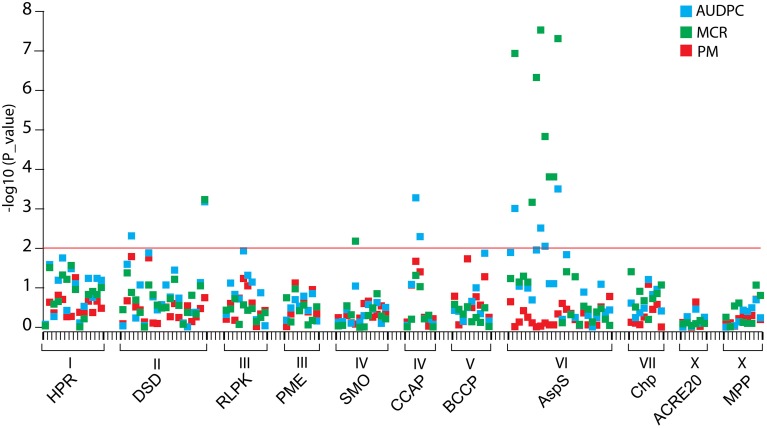
Linkage plot for SNPs from 11 candidate loci. SNPs are plotted on the x-axis and the –log10 of the p-values on the y-axis. The traits AUDPC, MCR, and PM are shown by blue, green, and red squares, respectively. The threshold p-value p = 0.01 is indicated by the horizontal line. Gene acronyms and chromosome positions are shown below the x-axis.